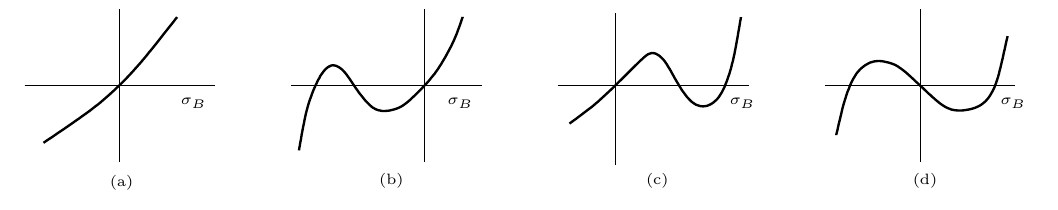
Figure 5 . E(cid:11)ective potential for x 6 > (cid:30) 2